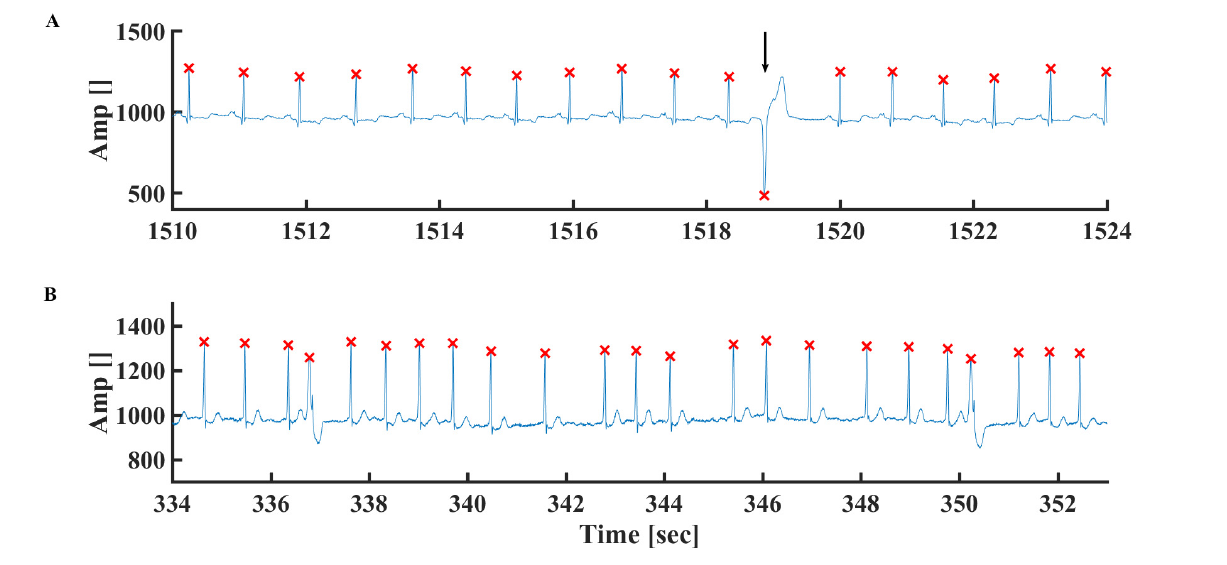
Figure 7. (A) Premature ventricular contraction. Data from MIT-BIH Arrhythmia Database #101. (B) Premature atrial contraction (PAC). Data from MIT-BIH Arrhythmia Database #221. The “x” symbol represents the R peak detected by the algorithm. The arrow represents